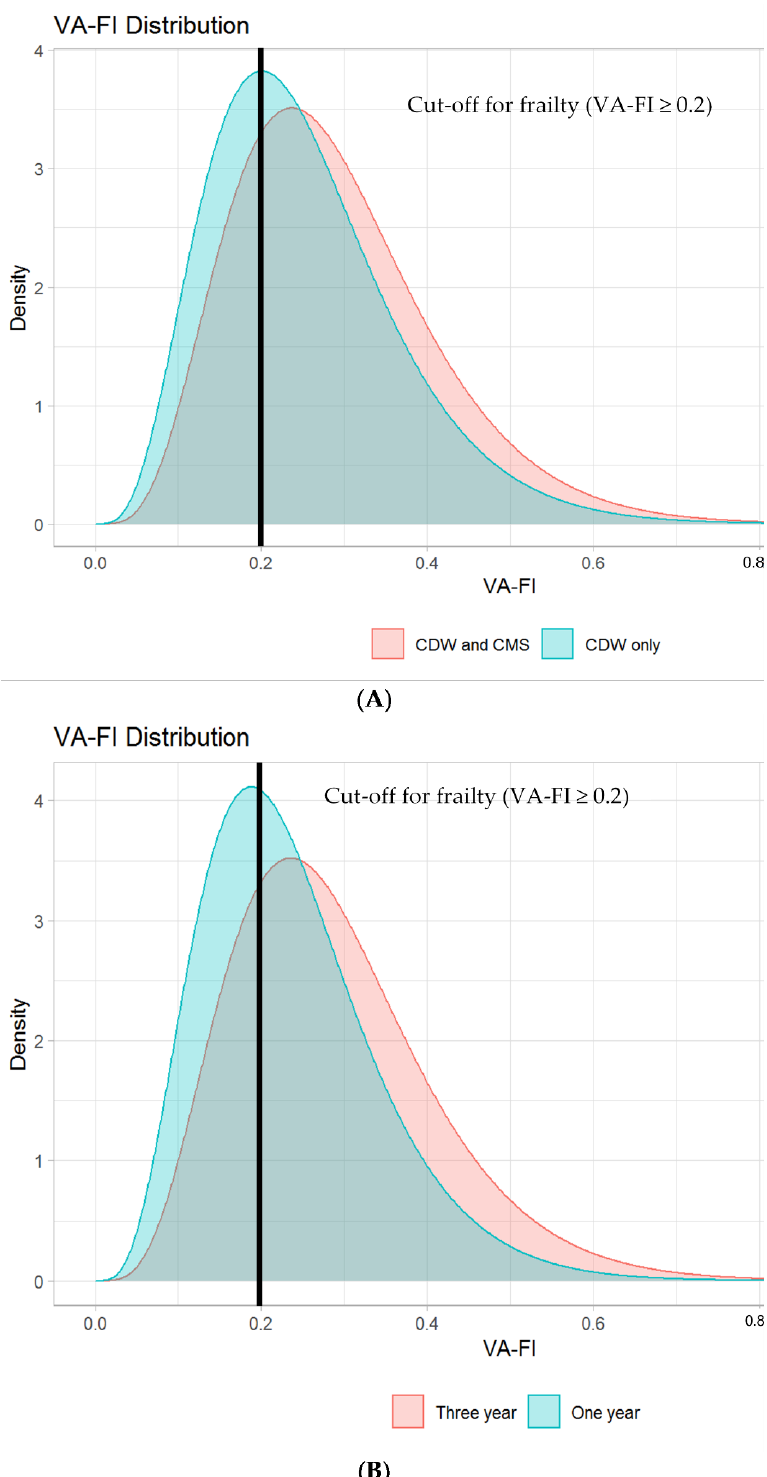
Figure 2. ( A ) Distribution of VA-FI-10 in 4924 transplant-ineligible older veterans treated with medical myeloma therapies, measured using data from both the VA Corporate Data Warehouse (CDW) and Centers for Medicare and Medicaid Services (CMS, red histogram), compared to the distribution of VA-FI-10 measured using data from the VA Corporate Data Warehouse only (blue histogram). ( B ) Distribution of VA-FI-10 measured using CDW and CMS data and a 3-year assessment period (red histogram) compared with the distribution of VA-FI-10 measured using CDW and CMS data and a 1-year assessment period (blue histogram).